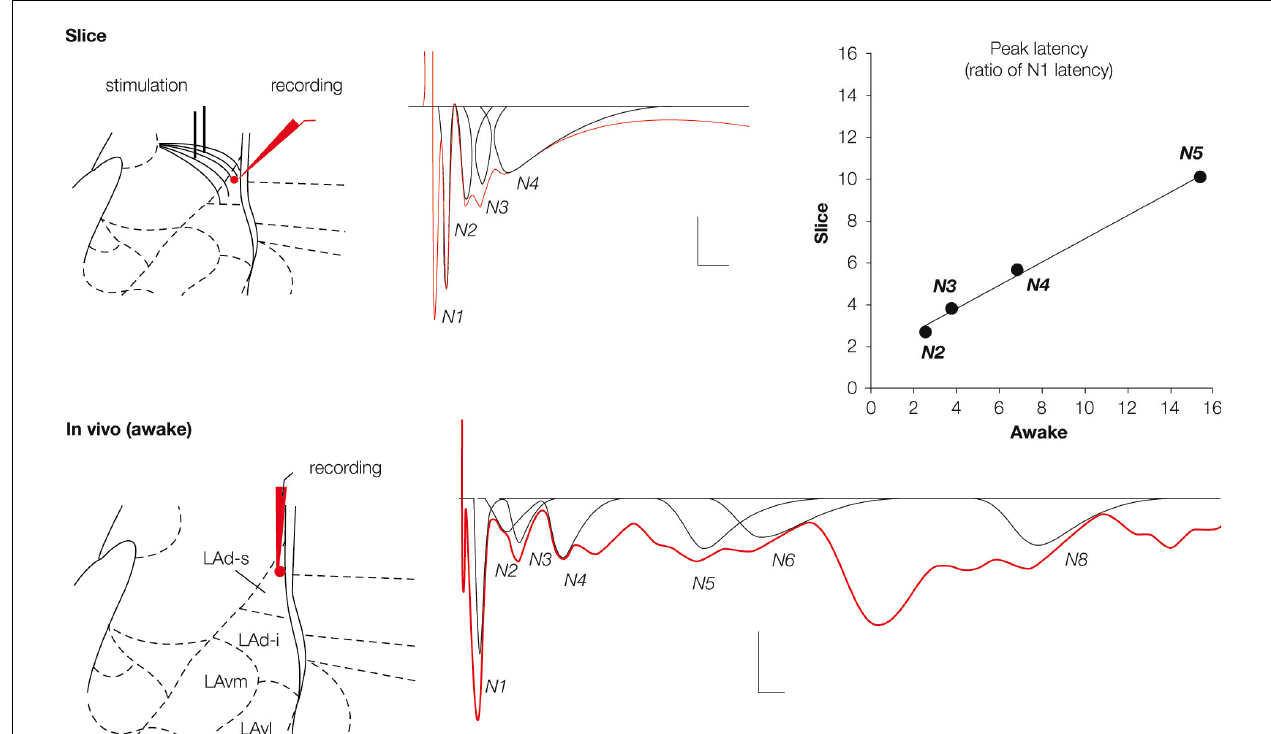
Figure 3 | Field potentials (in red) evoked in the lateral amygdala (LA) by stimulation of auditory afferents (internal capsula in vitro , auditory thalamus in vivo ) showed multiple negative potentials both in vitro (slice) and in vivo (awake rat). Scale: 0.1 mV, 10 ms. These waves represent a monosynaptic response (N1) followed by polysynaptic activity. We developed a method for fi tting and extracting peaks that represent reliable synchronized activity (in black). Five and nine peaks were isolated in the slice and the